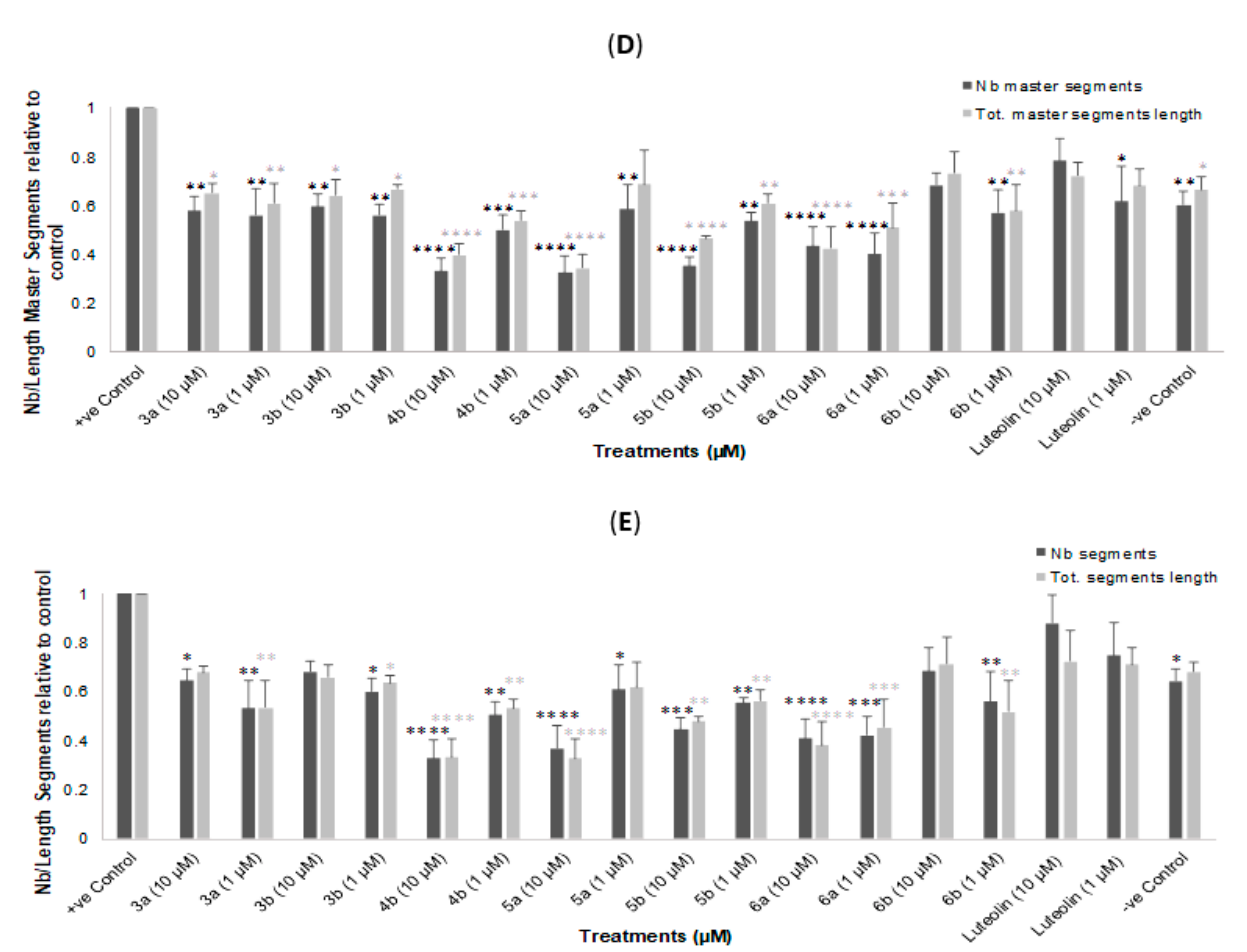
Figure 2. Antiangiogenic activity of flavonoid derivatives on in vitro HUVEC tube formation after 12 h expressed as a ratio to the +ve control (10 ng/mL VEGF-enriched media). ( A ) Representative images of tube formation assay at 4× magnification. Images were analysed using Angiogenesis Analyzer macro in ImageJ software; ( B ) number of junctions, ( C ) number of meshes, ( D ) number and length of master segments and ( E ) number and length of segments. Data are expressed as mean ± standard error of the mean (SEM), n = 3. Statistical significance was estimated with respect to the +ve control by one-way ANOVA, followed by Dunnett’s multiple comparison test (* p < 0.05, ** p < 0.01, *** p < 0.001, **** p < 0.0001).